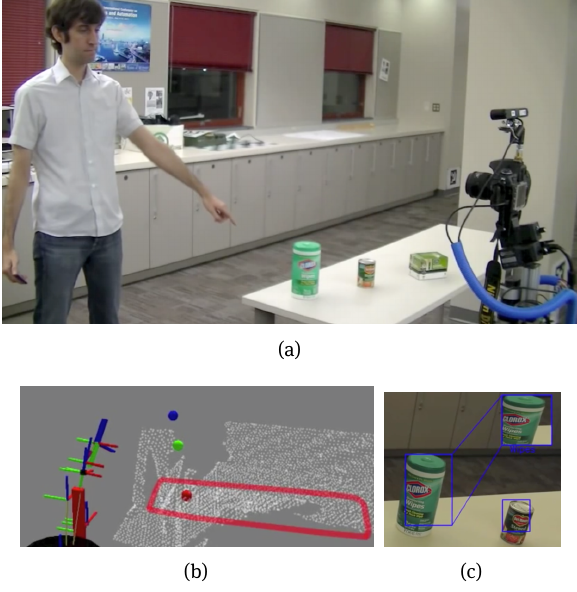
Figure 5: a) A user pointing at an object; b) A detected pointing gesture (blue and green spheres) and the referenced object (red sphere); c) Features are extracted from an image patch correspond- ing to the cluster and annotated with the provided label.